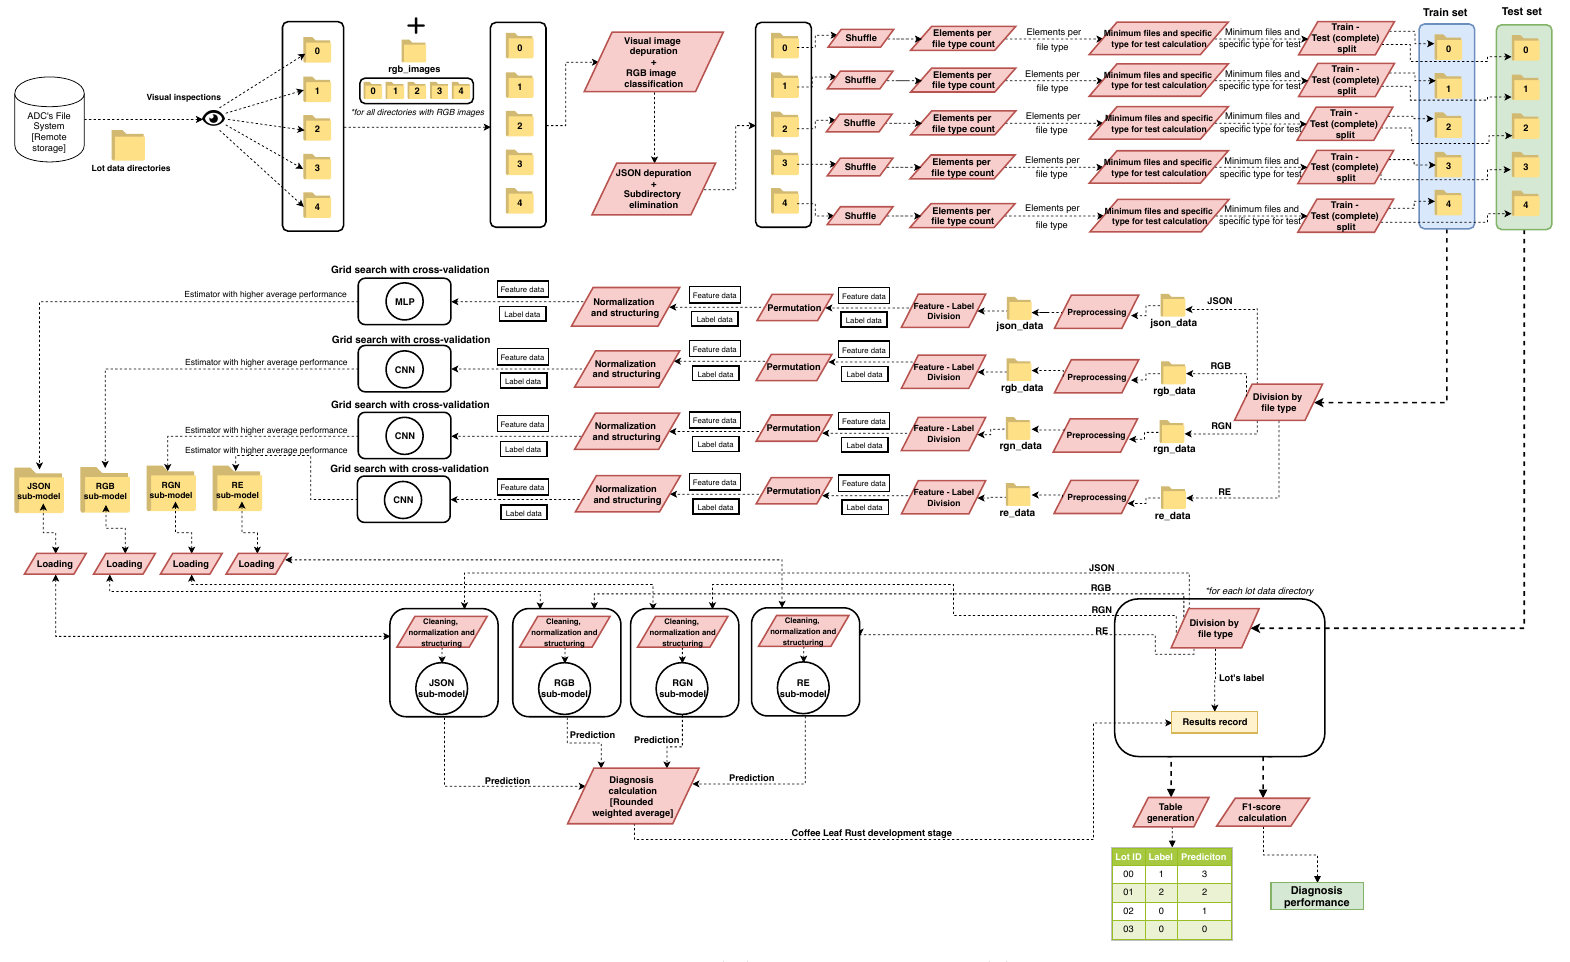
Figure A2. Detailed Data Management